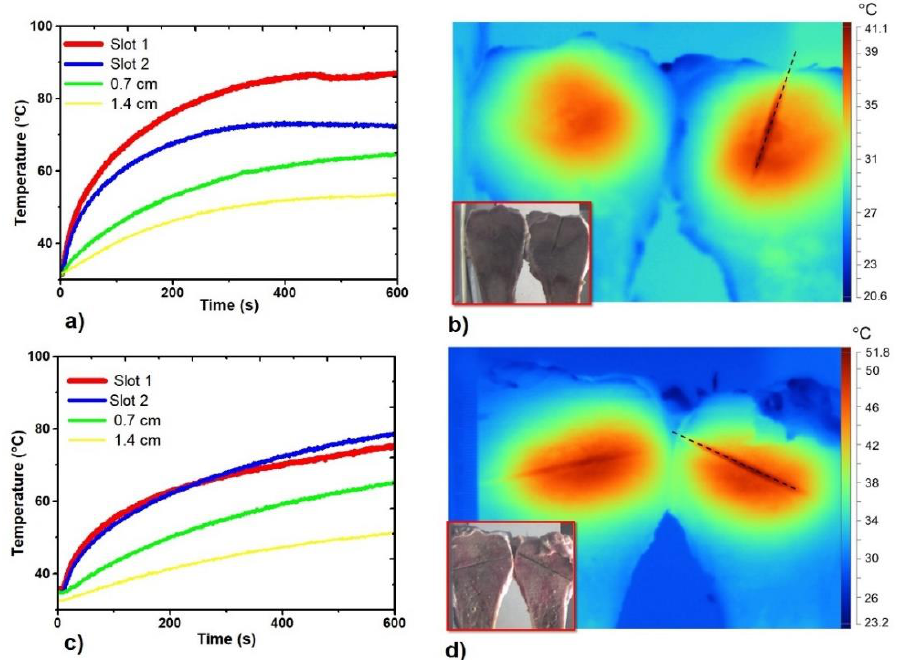
Figure 6. Temperature profiles and thermal distributions generated by the double slot antenna. ( a ) Temperature profiles generated by the antenna inserted at 3.5 cm; ( b ) Thermal distribution generated by the antenna inserted at 3.5 cm; ( c ) Temperature profiles generated by the antenna inserted at 5 cm; ( d ) Thermal distribution generated by the antenna inserted at 5 cm. The inset figure in ( b , d ) shows the two sections of the porcine bone, while the black dashed line describes the place where the antenna was inserted.